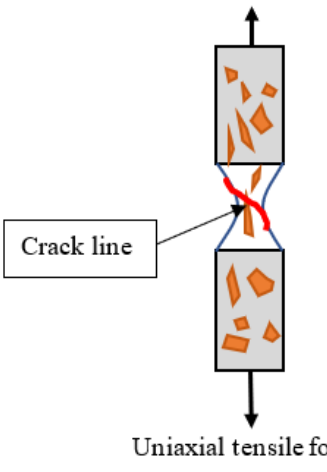
Figure 3. Crack propagation of micron coir filler composite.